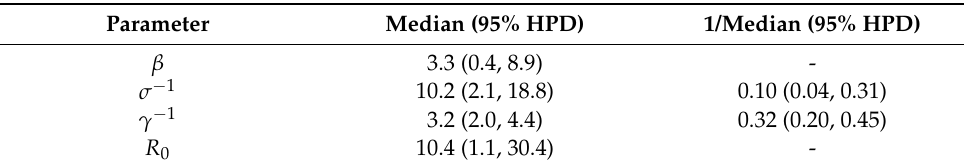
Figure 2. Frequency histogram showing counts of animals showing clinical signs and counts of an- imals that died as a function of calendar date. Table 2. Descriptive statistics of the posterior distributions of the transmission coefficient β , the average latent period (days) σ − 1 , the average duration of infectiousness (days) γ − 1 and the basic reproductive number R 0 .